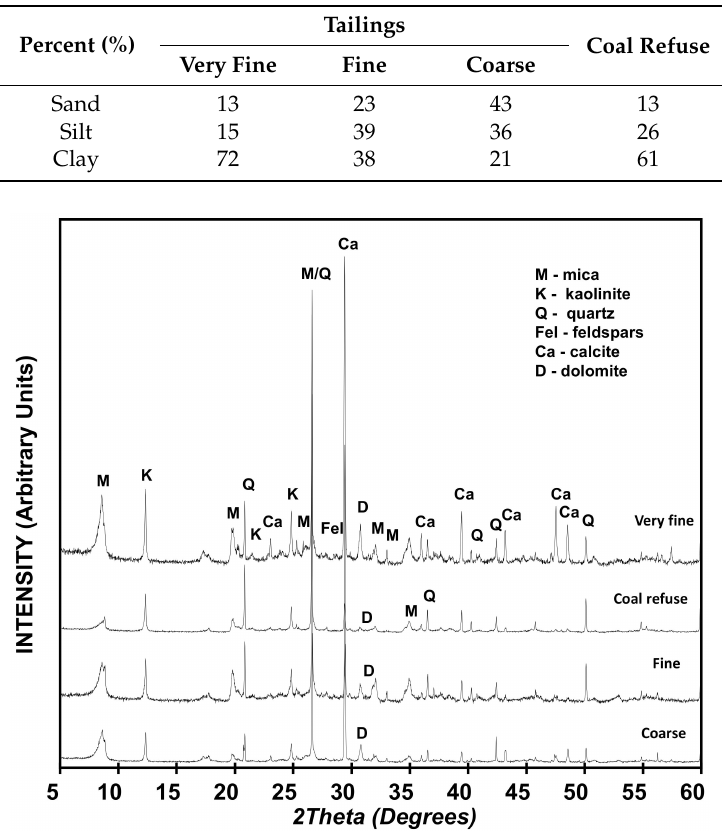
Table 2. Granulomety of the raw tailings samples.